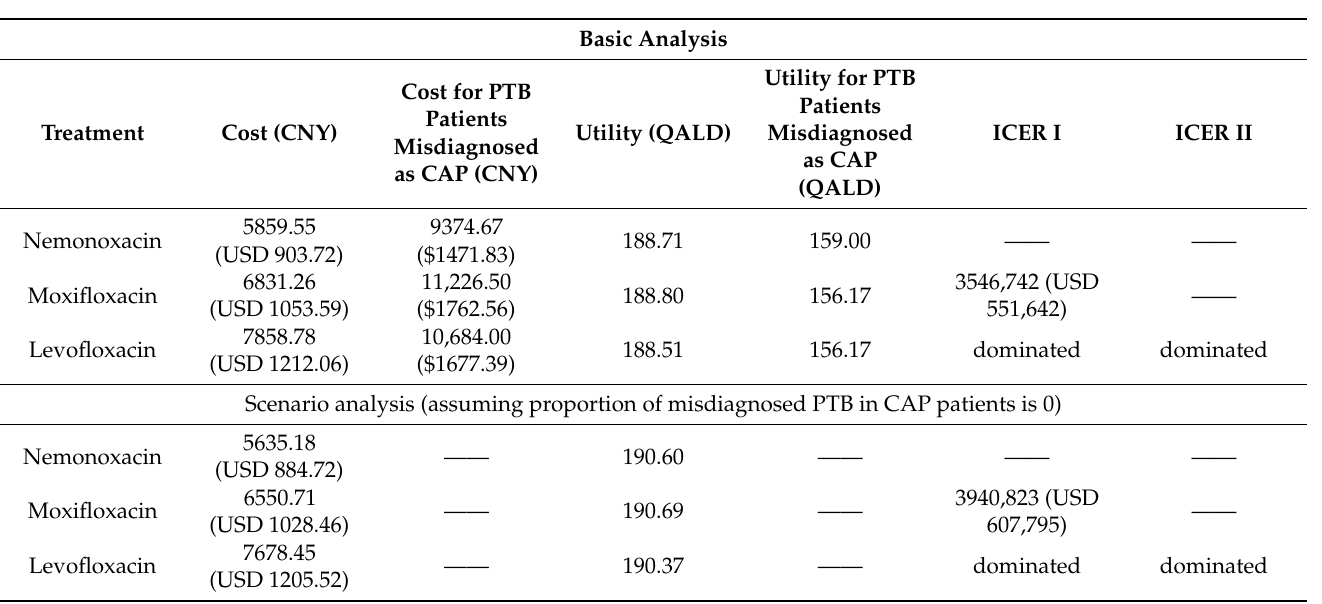
Table 2. Basic analysis and scenario analysis